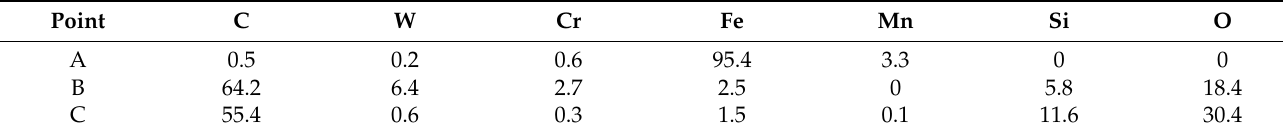
Table 3. Chemical composition at typical position of wear scar (wt. %).